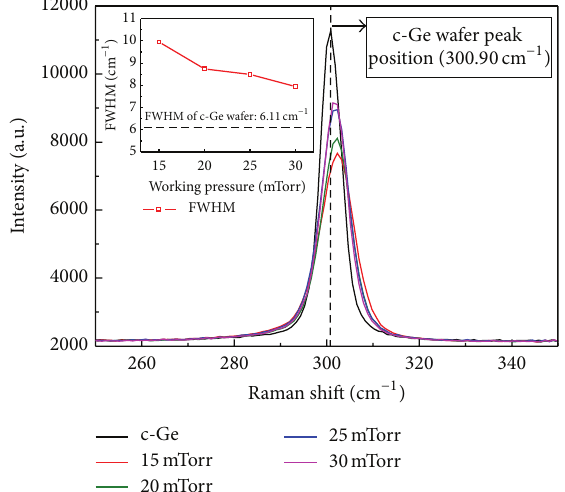
Figure 6: Raman spectra for c-Ge wafer and different Ge epilayer grown by different working pressures. The dash line shows that the peak position of c-Ge wafer is 300.90 cm −1 . The inset shows the FWHM of Ge TO mode of Ge epilayers compared with the FWHM of c-Ge wafer (dash